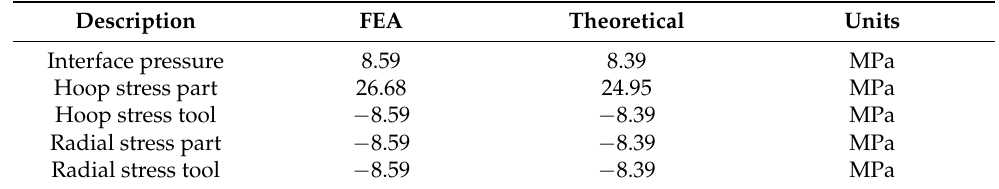
Table 8. Comparison of theoretical vs FEA results carried out for validation of the FEA modelling